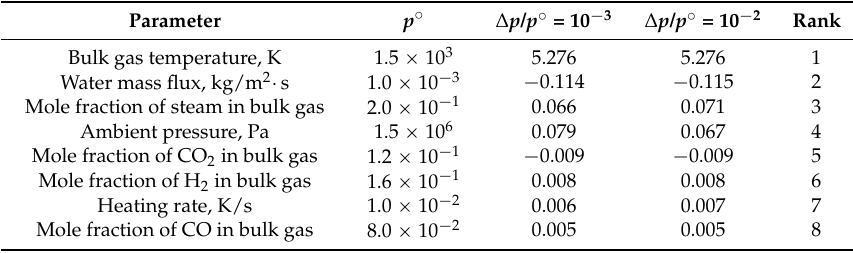
Table 18. Sensitivity of the cavity growth rate to changes in operating conditions [76].